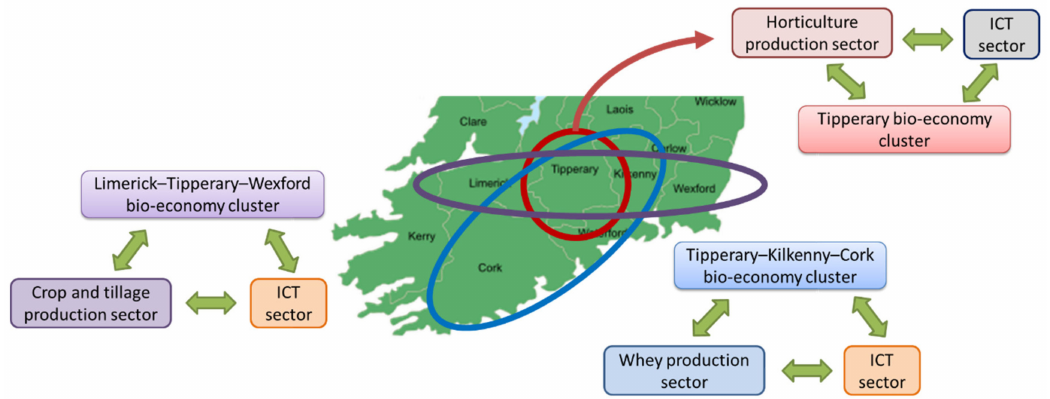
Figure 9. Cross-sector interconnections created in the frame of the DIH, south-east Ireland (Ireland). Please note that for the sake of clarity, interconnections created by combined biomass supply chains are not